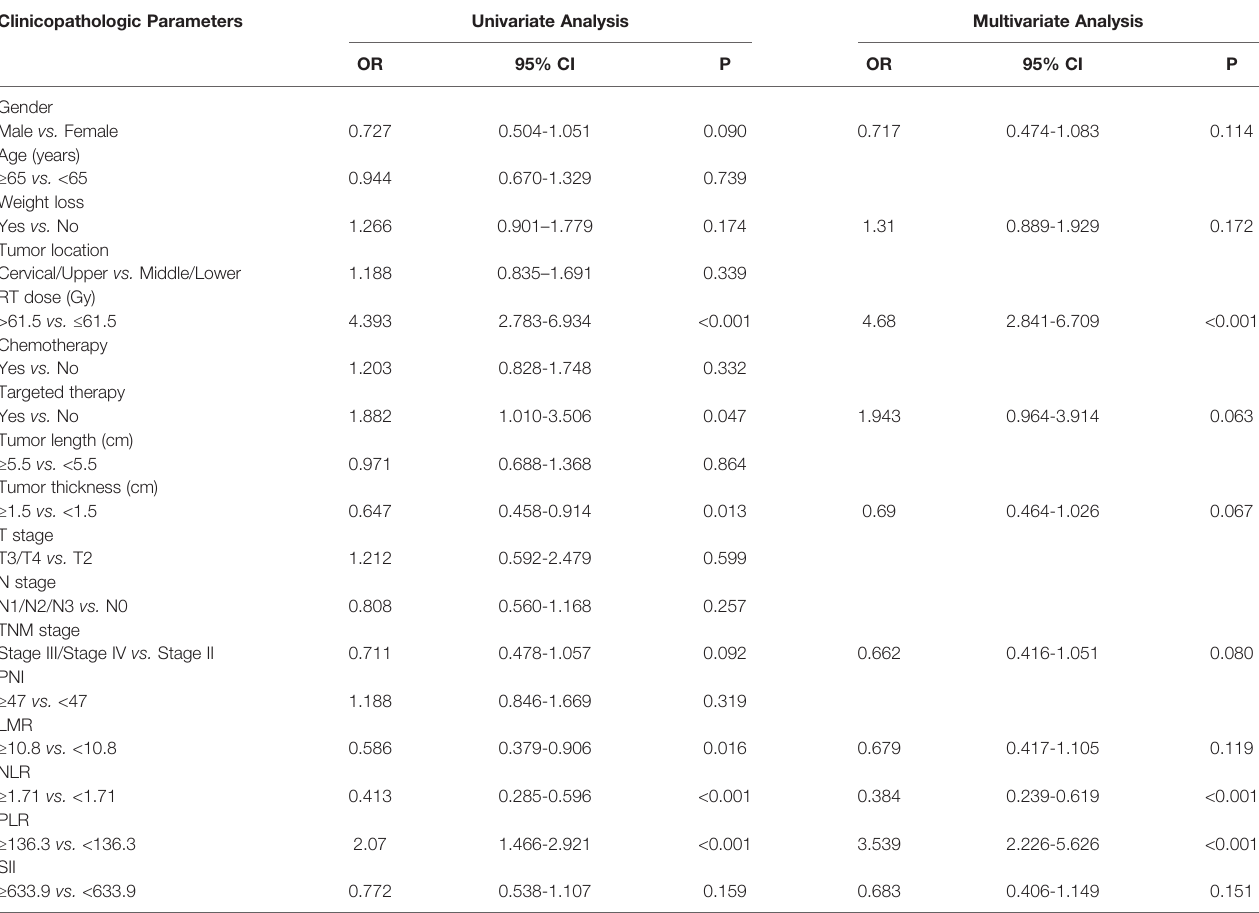
TABLE 2 | Univariate and multivariate analysis of the clinical, dosimetric factors and in fl ammation indexes in predicting grade ≥ 2 RE. Clinicopathologic